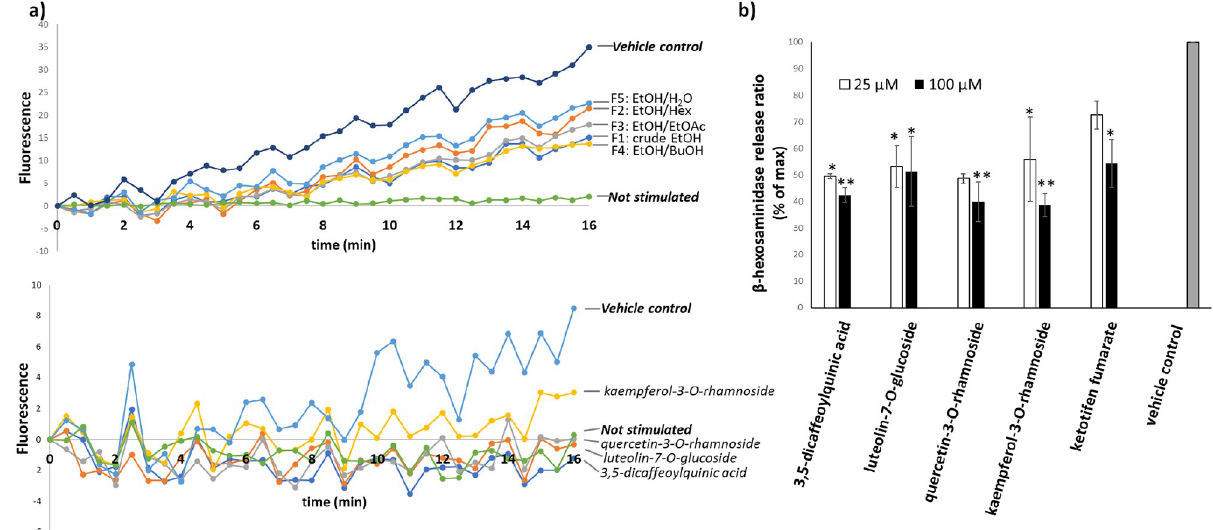
Fig 5. Inhibitory effects on IgE-mediated RBL-2H3 cell degranulation. a) The effects of the extracts (100 μ g/mL) and active compounds (25 μ M) derived from X . tridentata on intracellular ROS generation b) The effects of active compounds and ketotifen fumarate (25 and 100 μ M) on β - hexosaminidase release. Ketotifen fumarate was used as a positive control. The values are presented as means ± SEM (n = 3). � p < 0.05 and �� p < 0.001, compared with the vehicle control.